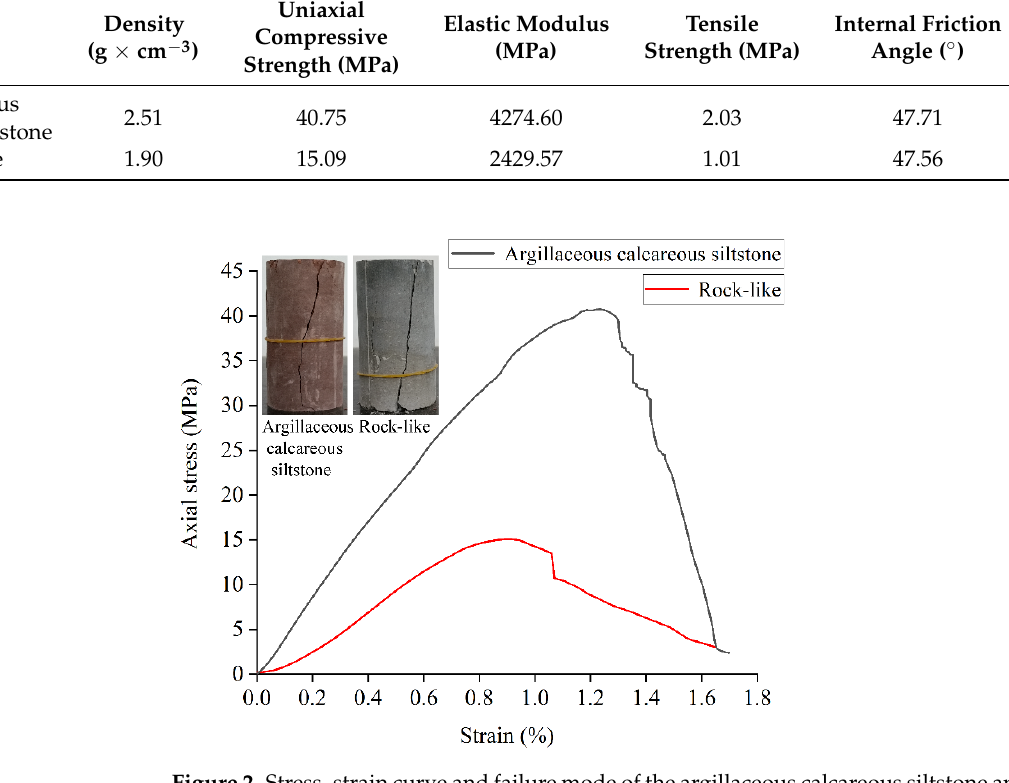
Figure 2. Stress–strain curve and failure mode of the argillaceous calcareous siltstone and the rock-like material.